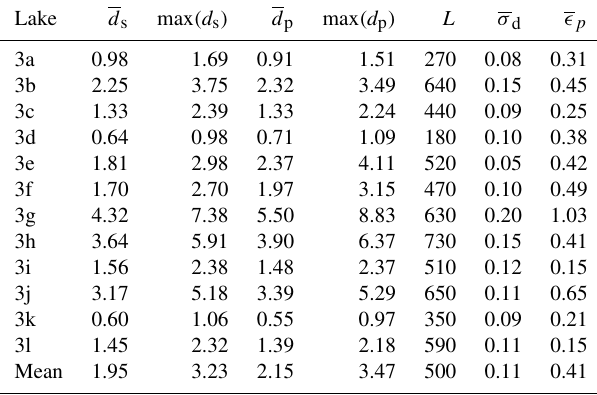
Table 1. Cumulative statistics for ATM supraglacial lakes explored in this study, including mean and maximum signal-based depth ( d s ) and polynomial-based depth ( d p ), along-track extent L , mean lake depth uncertainty ( σ d ), and mean polynomial estimation error ( (cid:15) p ). Units are in meters.